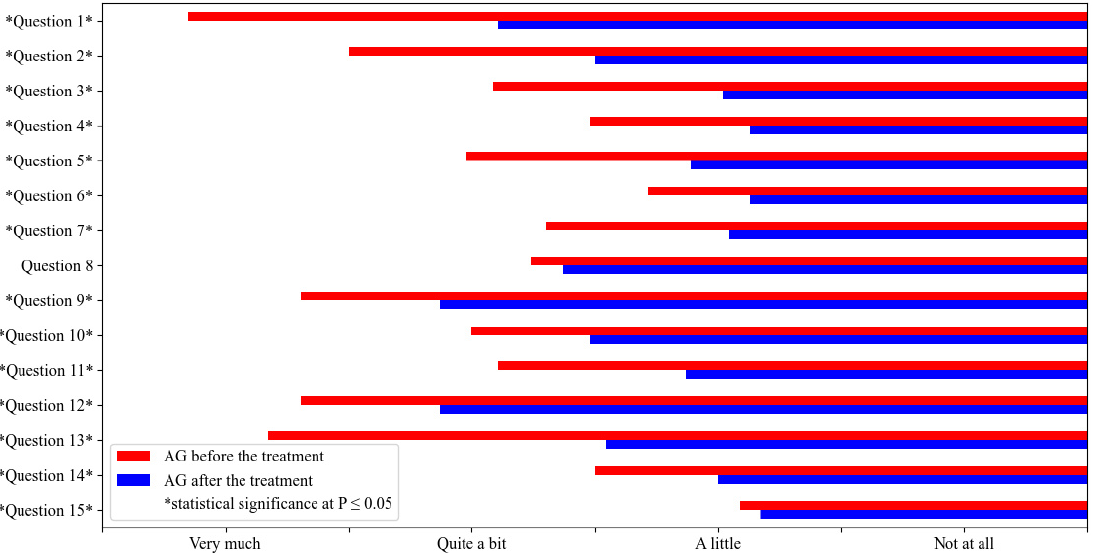
Figure 2. Statistical comparison of the quality of life of ASIT—treated dogs (AG) before the treatment (QoL1 AG) and after the treatment (QoL2 AG). The mean values are represented in the figure and statistical significance at p ≤ 0.05 is marked with * .